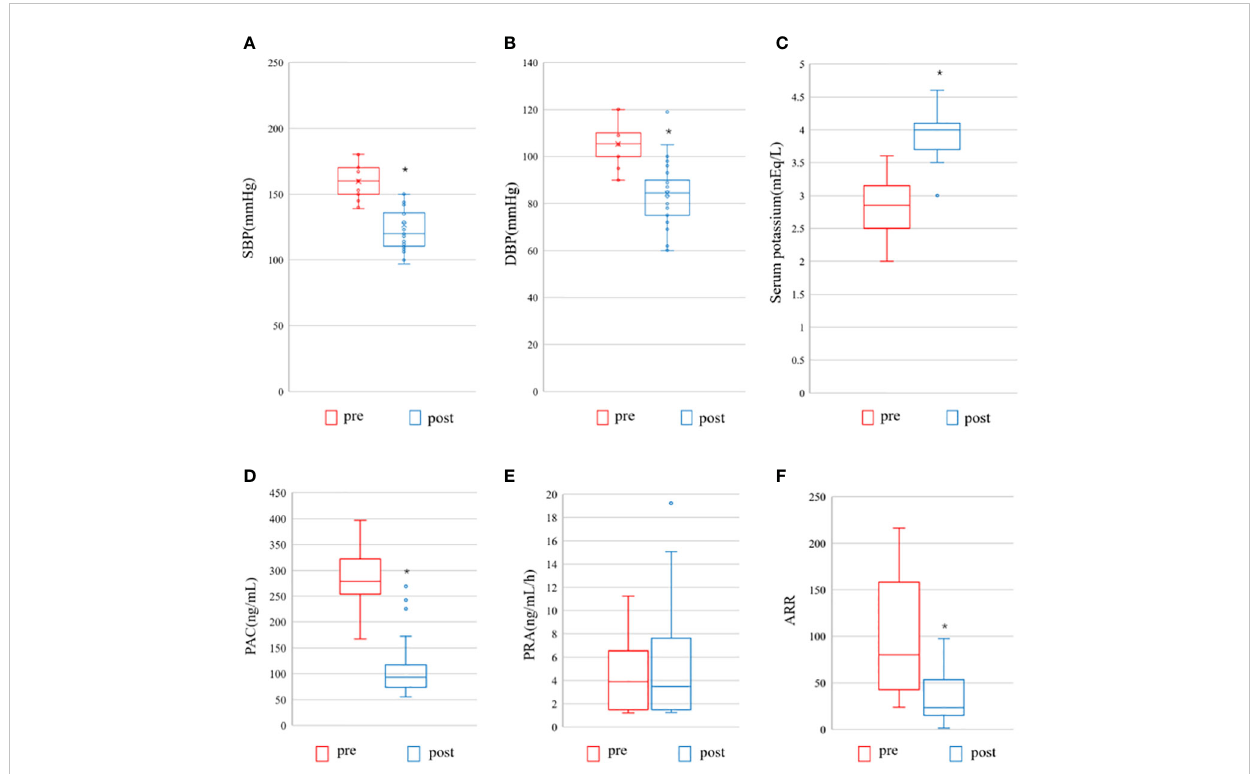
FIGURE 6 Pre- and postoperative evaluation of the AVS- unilateral primary aldosteronism patients undergoing surgery. Pre, pre-operation; post, post- operation; (A) SBP, systolic blood pressure; (B) DBP, diastolic blood pressure; (C) Serum potassium; (D) PAC, plasma aldosterone concentration; (E) PRA, Plasma renin activity; (F) ARR, Aldosterone-to-renin ration. The data are shown as box plots, were analyzed using the Wilcoxon signed-rank test. *indicates statistical signi fi